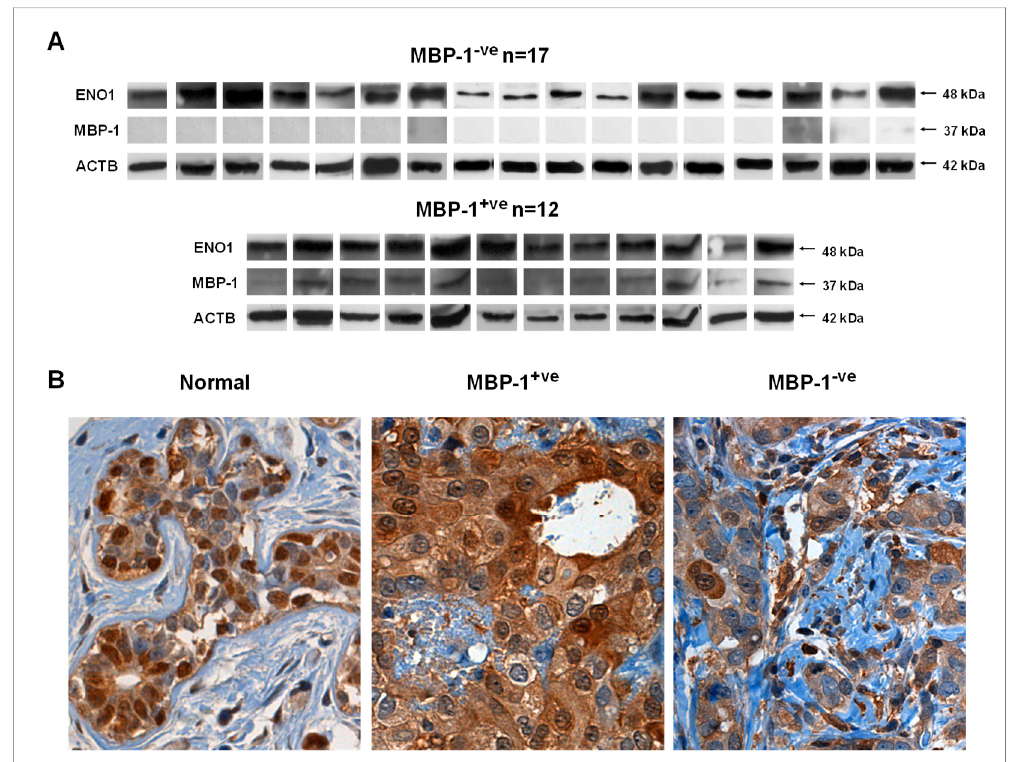
Figure 3. Myc promoter-binding protein-1 (MBP-1) expression in breast cancer tissues. ( A ) Western blot detection of ENO1 and MBP-1 in tumor tissues from 29 from breast cancer patients; ( B ) representative immunohistochemical staining on sections of a healthy mammary tissue and two breast cancer tissues, respectively positive and negative for MBP-1 expression. Cytoplasmic staining is referred to ENO1 while nuclear staining is attributable to MBP-1 expression (Magnification 400×).